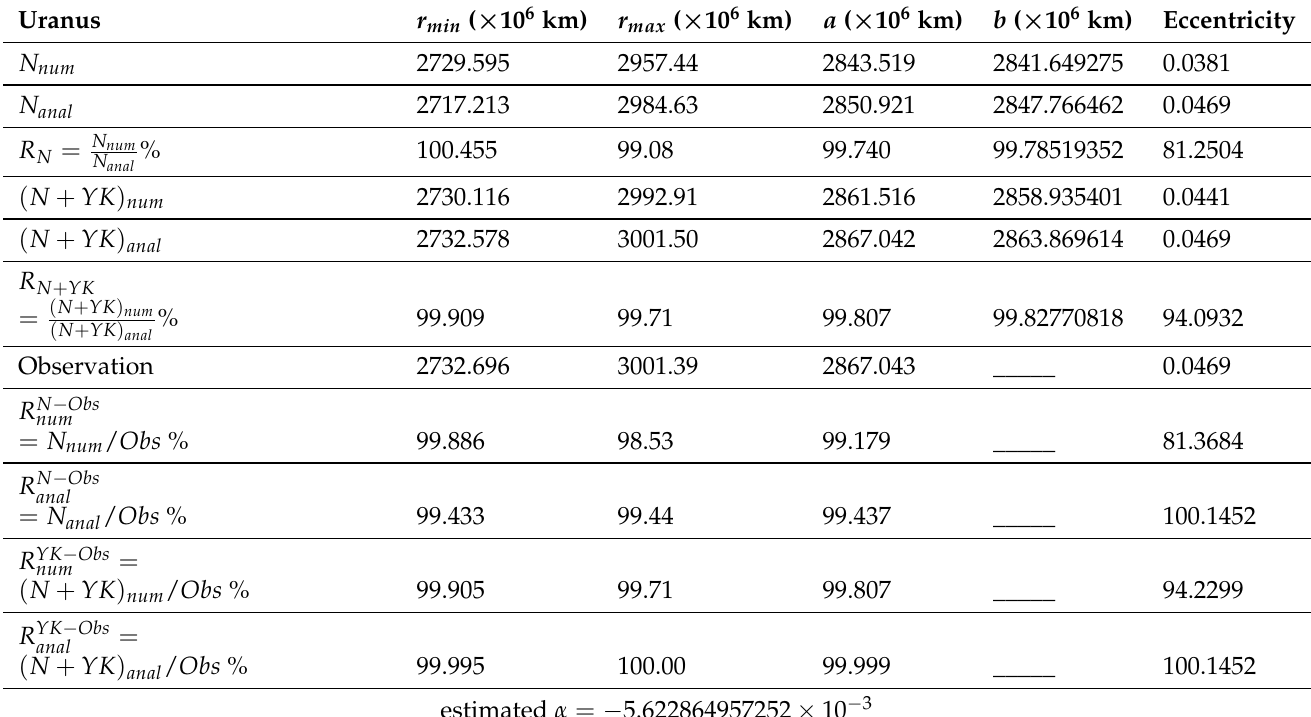
Table A14. The values of the calculated and observational astronomical parameters, for estimated α , of the planet Uranus, whose number of moons is 0.